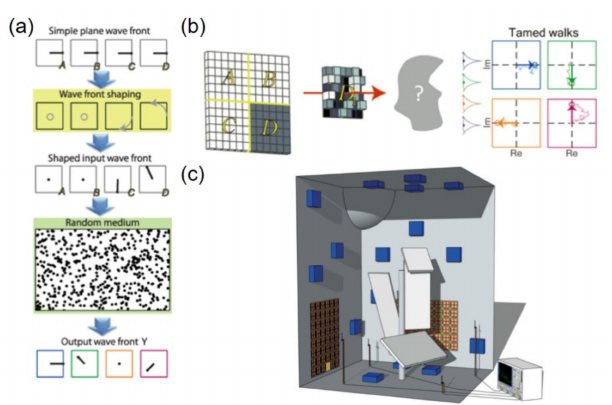
Figure 8. ( a ) Schematic the random medium scheme for wave-based analog computation; ( b ) tamed contribution of segment D to observation points; ( c ) experimental setup in a metallic cavity of irregular geometry. Adapted with permission from [146], APS,